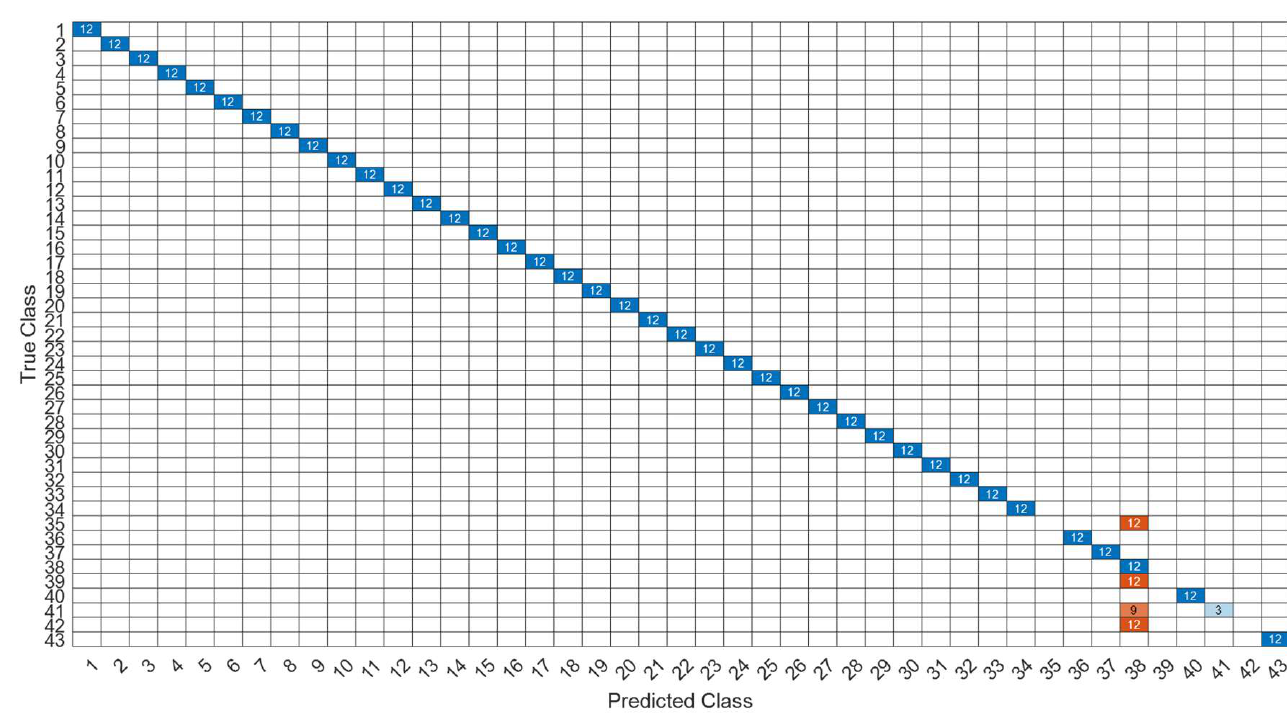
Figure 32. The confusion matrix of the CNN model with wavelet 40-features dataset.